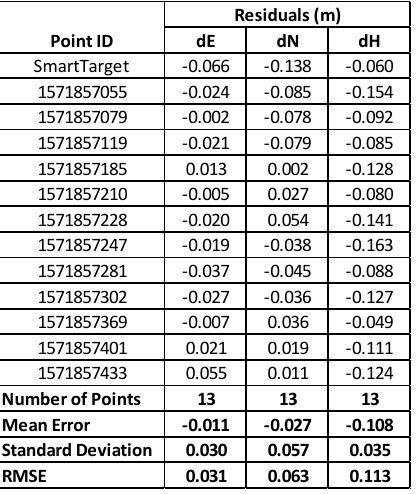
Table 4: Checkpoint Residuals Measured in Orthomosaic and